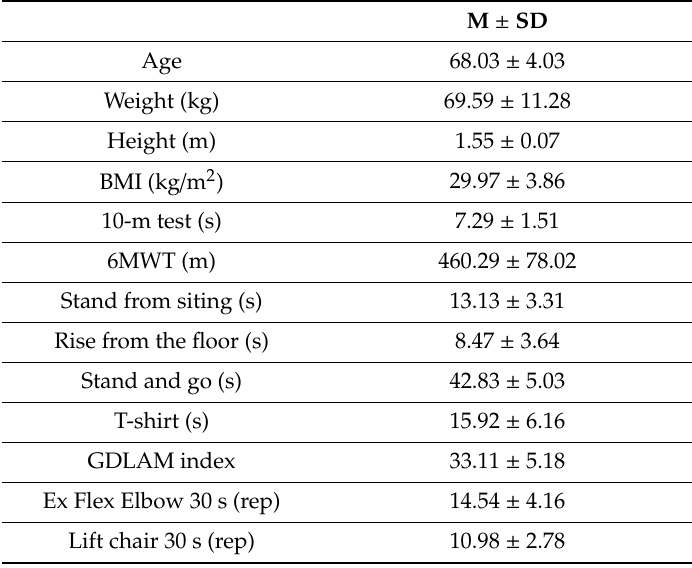
Table 2. Characteristics of the participants.